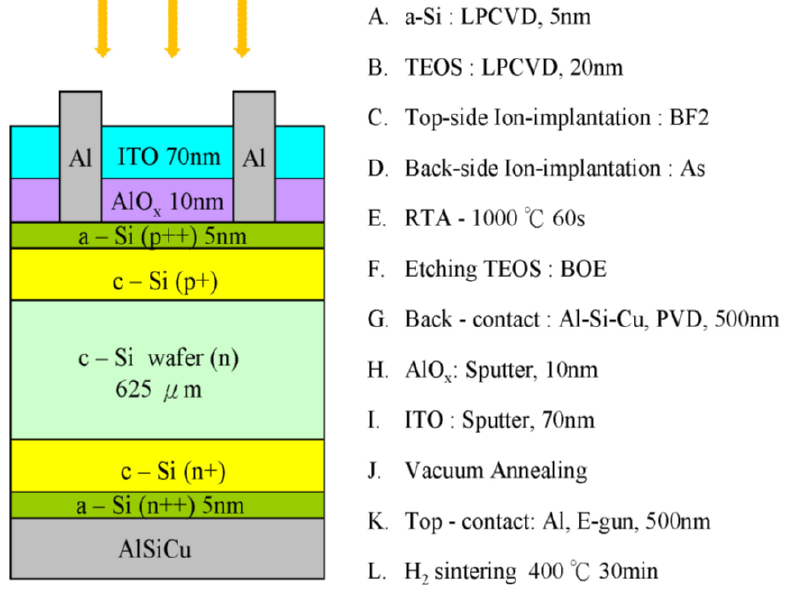
Figure 1. Heterojunction solar cell with AlO